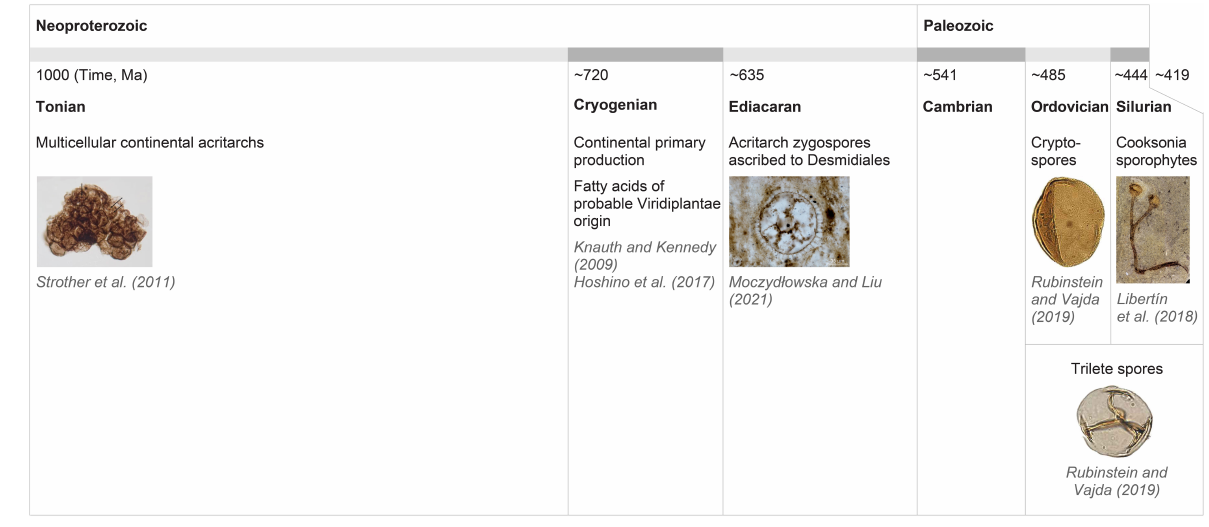
FIGURE 2 | Paleontological and geological evidence for the continental (most probably eukaryotic) organisms and primary production by photosynthetic organisms/plants from the Neoproterozoic through Cryogenian to the early Paleozoic. For our hypothesis, the existence of desmids in the early Ediacaran, as indicated by the Acritarch zygospores ascribed to Desmidiales (Moczydłowska and Liu, 2021), is of central